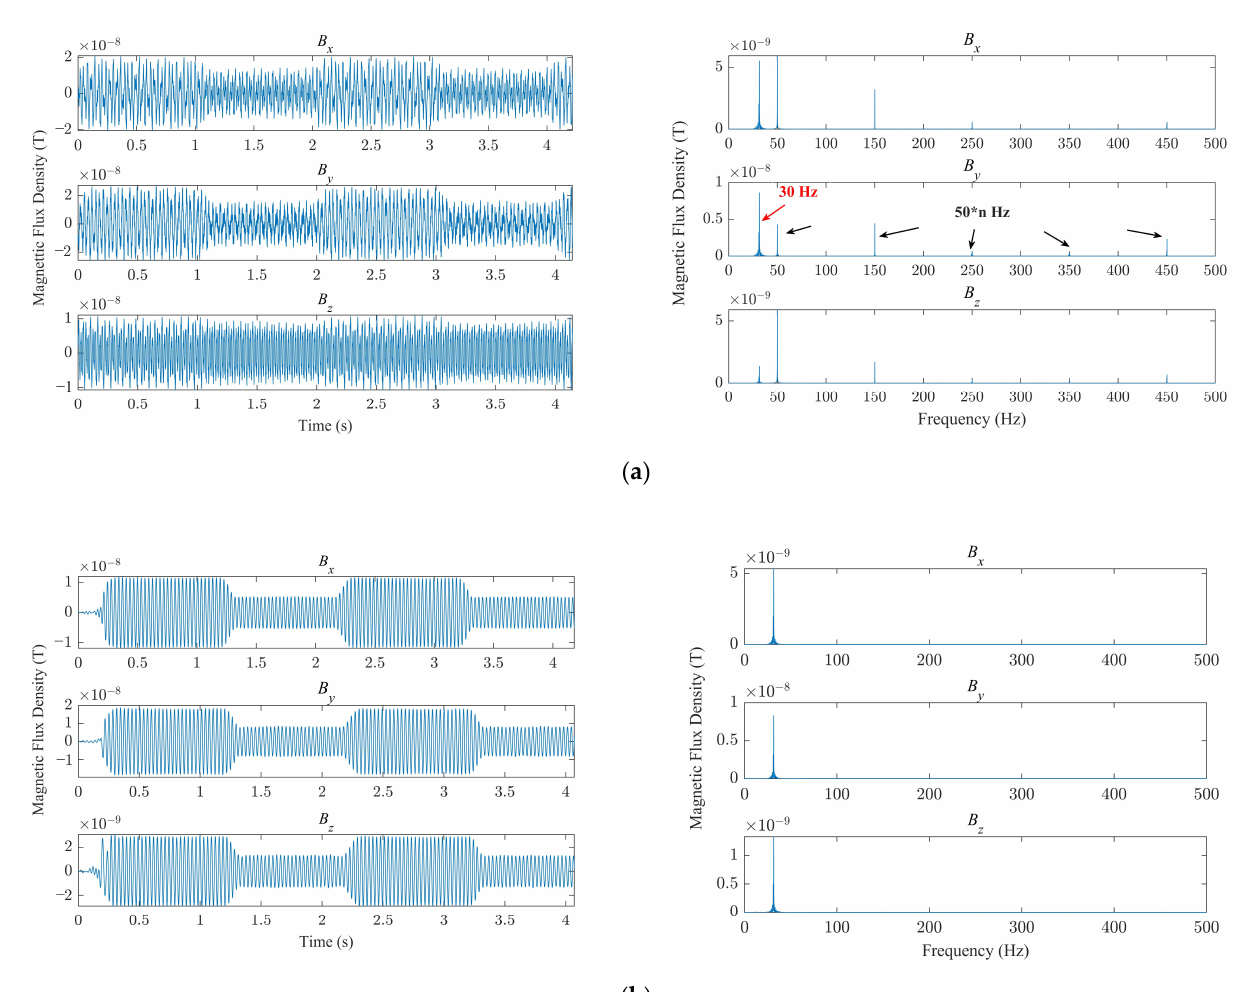
Figure 6. Three-dimensional magnetic flux density and its spectral characteristics: ( a ) before filtering; ( b ) after filtering.